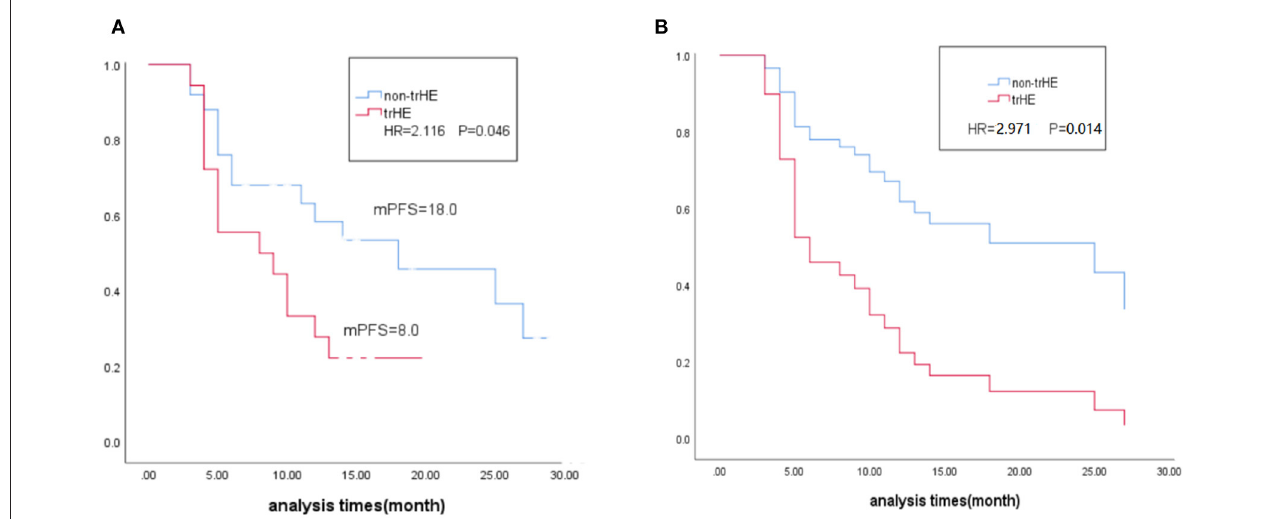
FIGURE 1 | (A) Kaplane-Meier survival estimates in relation to occurrence of trHE. (B) Multivariate Cox regression estimates in relation to occurrence of trHE, corrected for baseline LDH level, medication regimens and liver metastases. trHE, treatment-related hepatotoxicity defined as the increase of either ALT, AST, or bilirubin levels; mPES, median progression-free survival; HR, hazard ratio; LDH, lactate dehydrogenase.